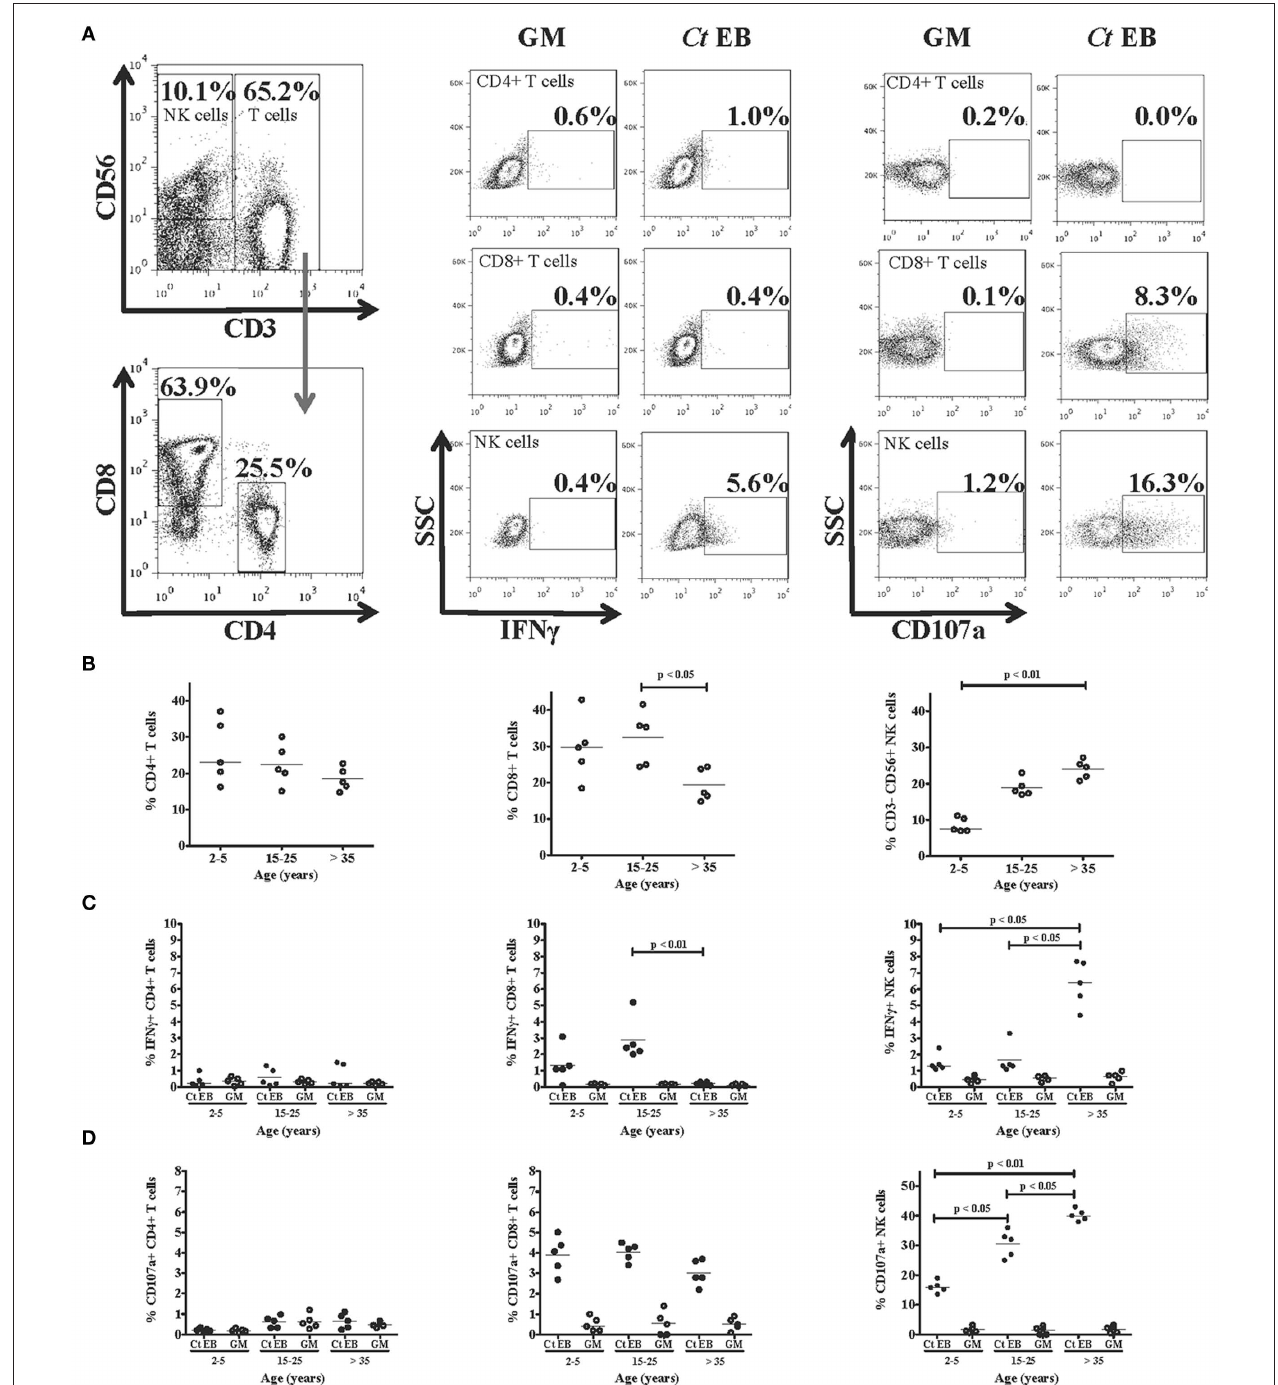
variation of CD8+ T and NK cell levels, whereas CD4+ T cell levels do not appear to vary with age. (C) The percentage of NK cells producing IFN γ significantly increased with age, while the percentage of CD8 + IFN γ+ cells significantly decreased in the > 35 years age group. The percentage of CD4 + IFN γ+ did not differ among the different age groups. (d) The percentage of CD107a + NK cells significantly increased with age, whereas levels of CD107a expression in CD8 + T cells did not differ with age. CD4 + T cells expressed negligible levels of